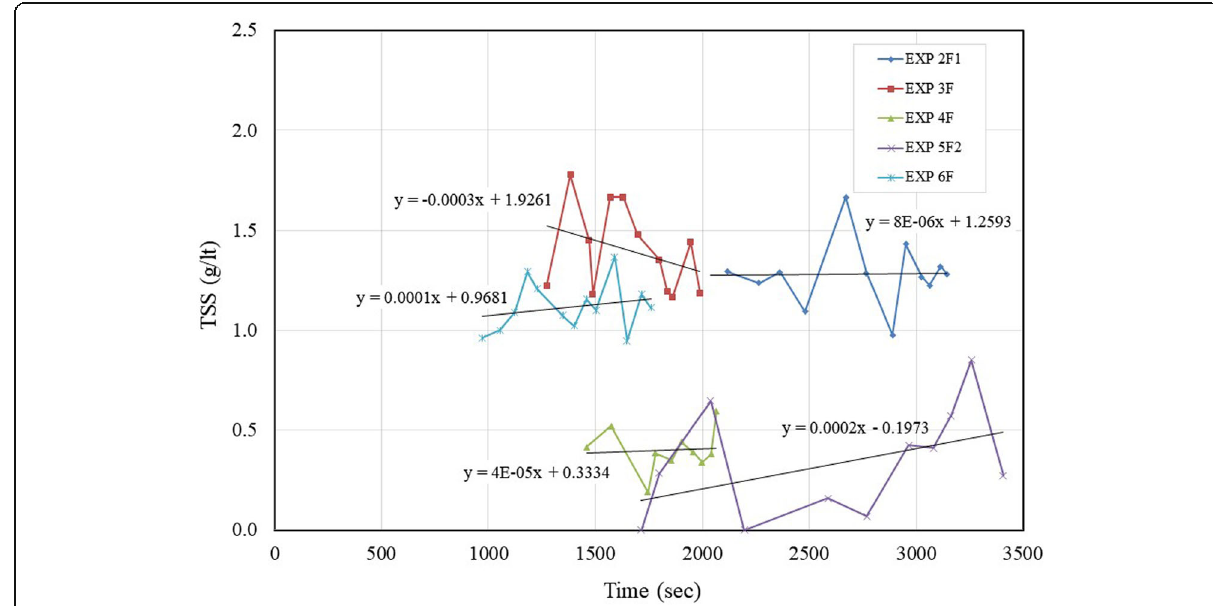
Fig. 10 Trend of TSS for different samples (failure